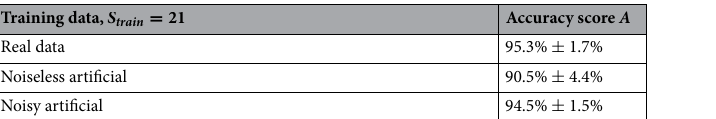
Table 2. Comparison of model accuracy for different types of training data: real images, artificial noiseless images, and artificial images with noise added as a post-processing filter.